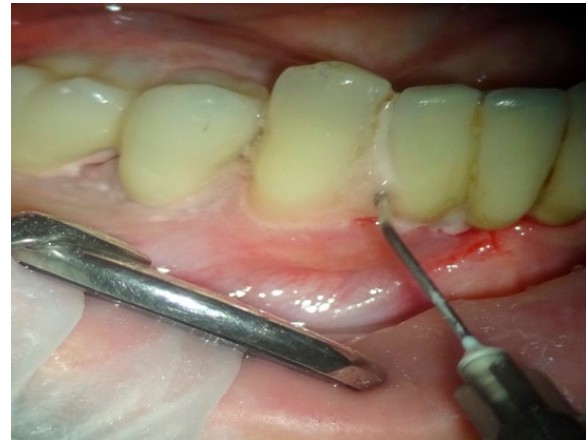
Figure 3. Irrigation with a Sioxyl solution .